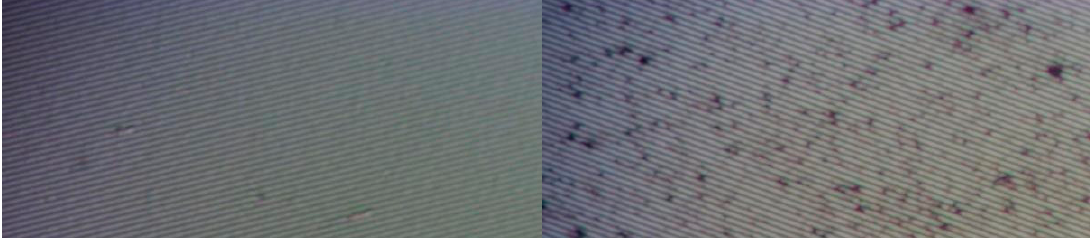
Figure 2. Optical microscope images of the nickel cast before ( left ) and after ( right ) machining, 400× magnification.